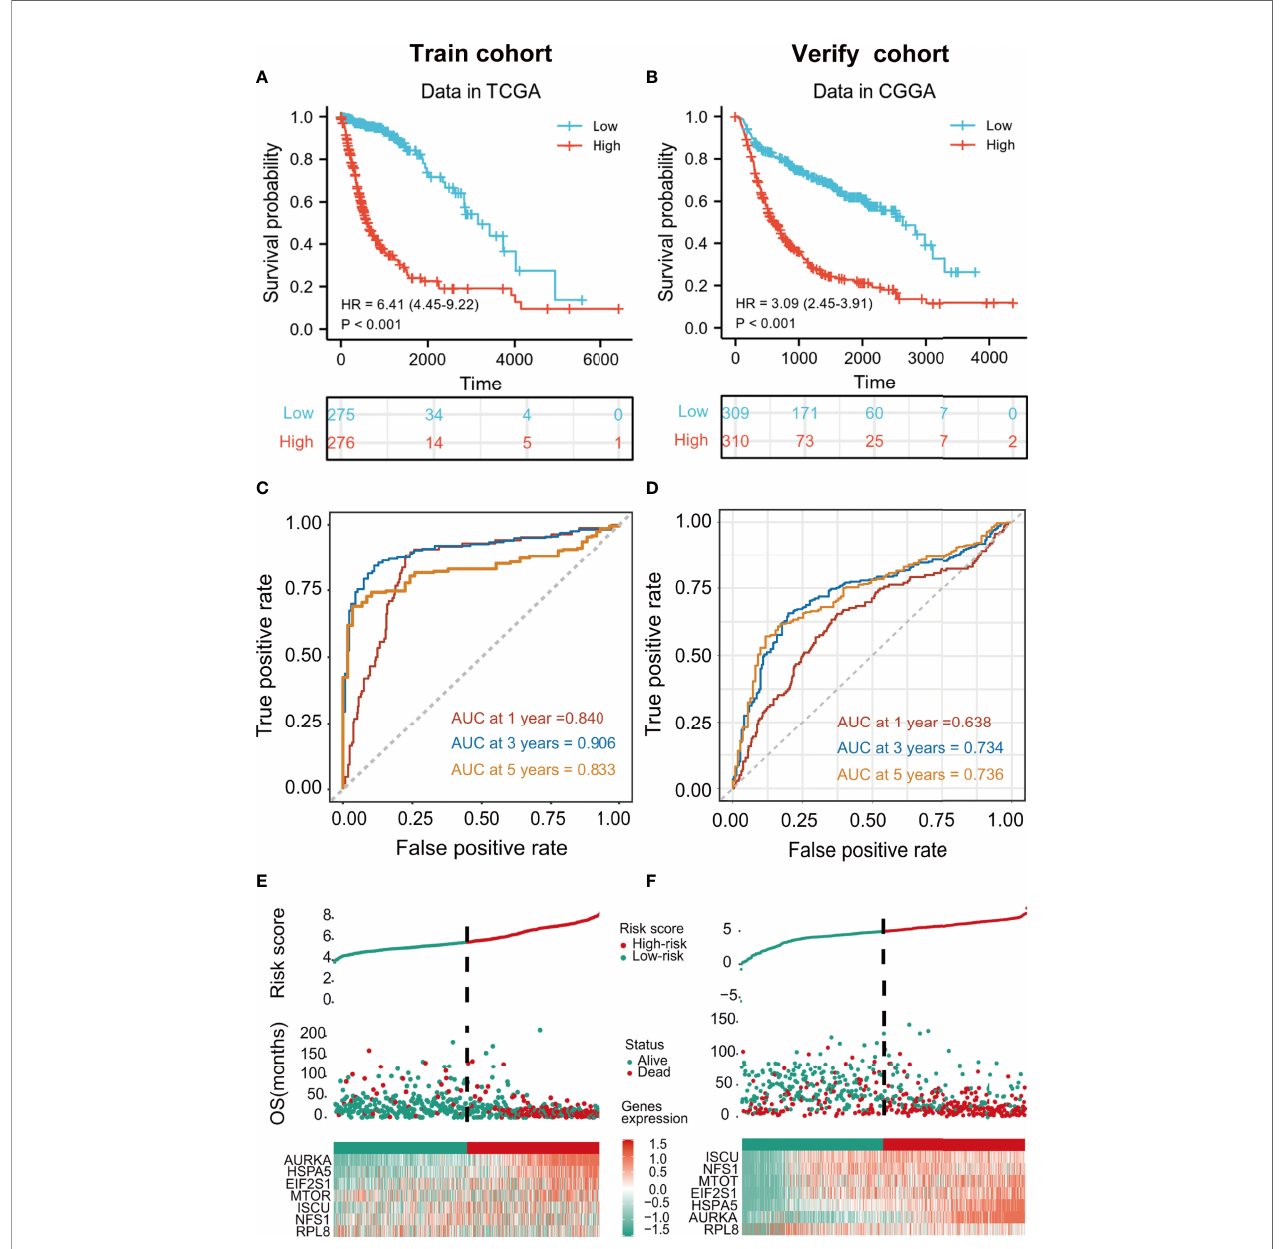
FIGURE 3 | Kaplan-Meier curves showing risk scores of FRG signature genes in both training and validation cohorts (p < 0.001) (A, B) . tROC curves for one-, three- and fi ve-year survival (C, D) . Heatmaps of risk score rankings, survival, and levels of cancer-essential FRGs in the training and validation cohorts (E, F)